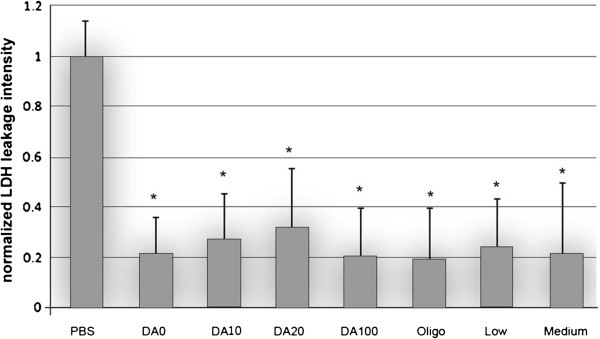
Quantification of the normalized fluorescence intensity of LDH leakage as a function of chitosan treatments. The fluorescence intensity in the PBS group was used as the control. Note that all chitosan treatments significantly decreased the fluorescence intensity of LDH leakage following the compression injury, *P < 0.05 (Dunnett test). A statistical difference was not observed between chitosan treatments of different DA and MW, P > 0.05 (Tukey test). N = 6.